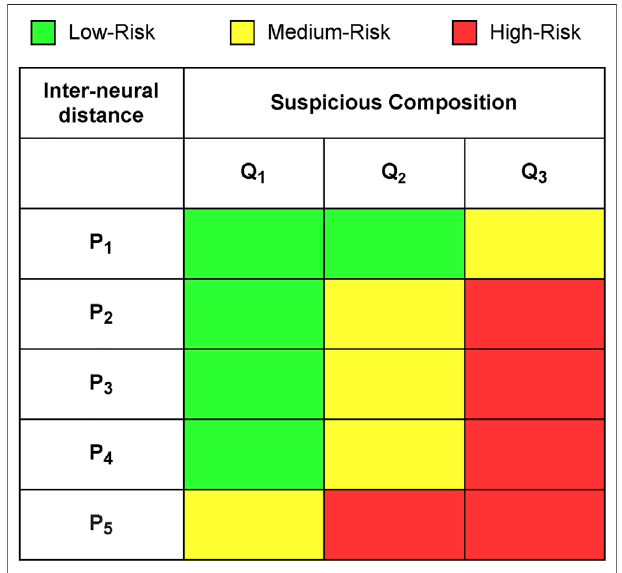
FIGURE 2 | SOM neurons risk categorisation